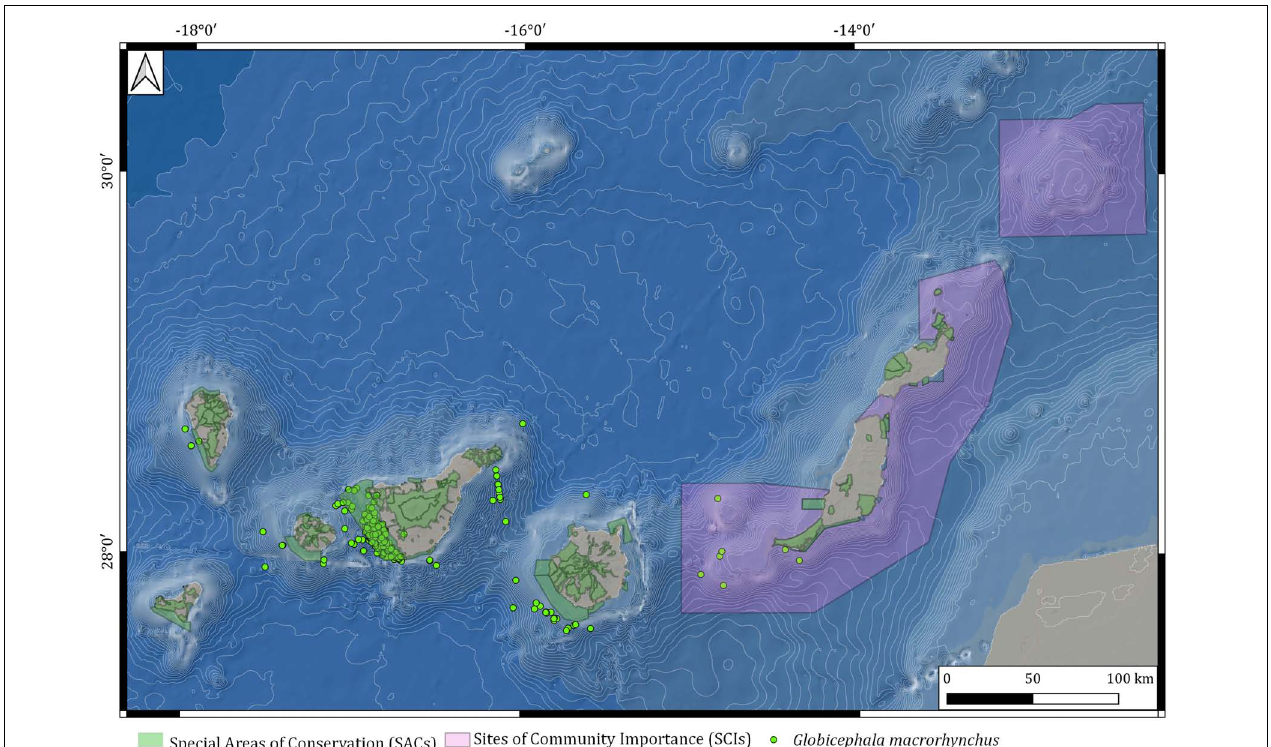
FIGURE 7 | Globicephala macrorhynchus spatial distribution around the Canary archipelago (green circles), including the Special Areas of Conservation (SACs; green color) and the Sites of Community Importance (SCIs; pink color).